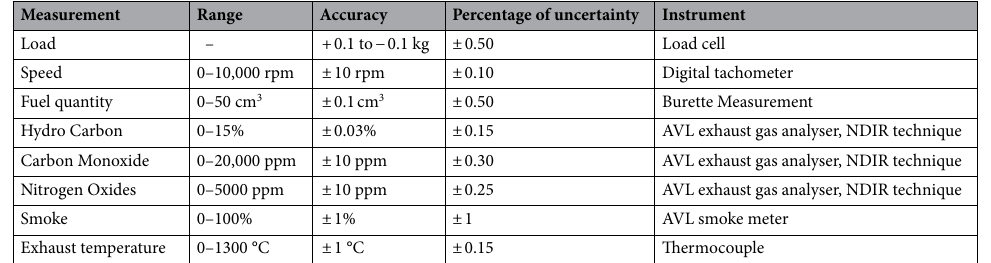
Table 3. Experimentation instruments details.